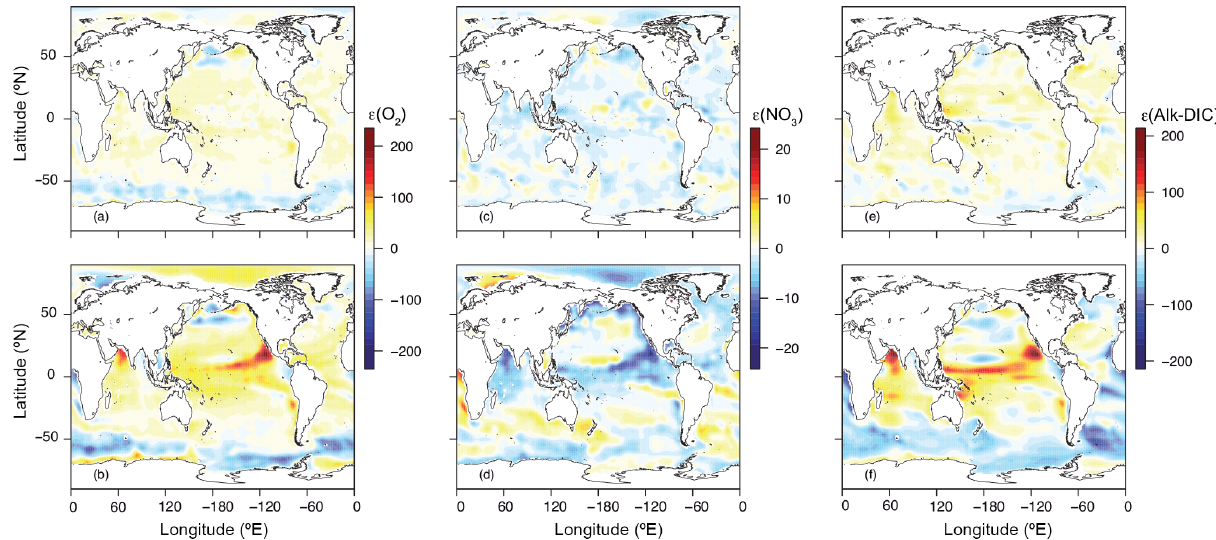
Figure 5. As Fig. 4 but for concentrations at 150m. Note that color shading does not represent the same amplitude in spatial biases as in Figs. 4 and 6.